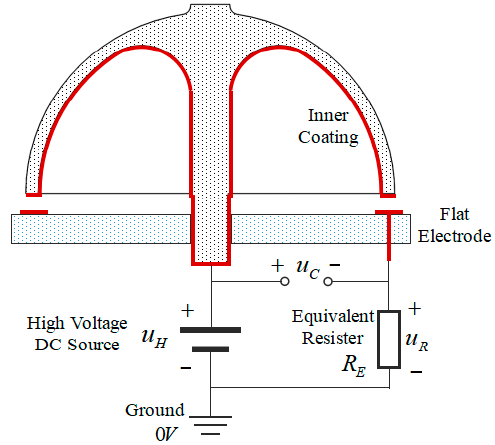
Figure 9. Schematic of signal converter.